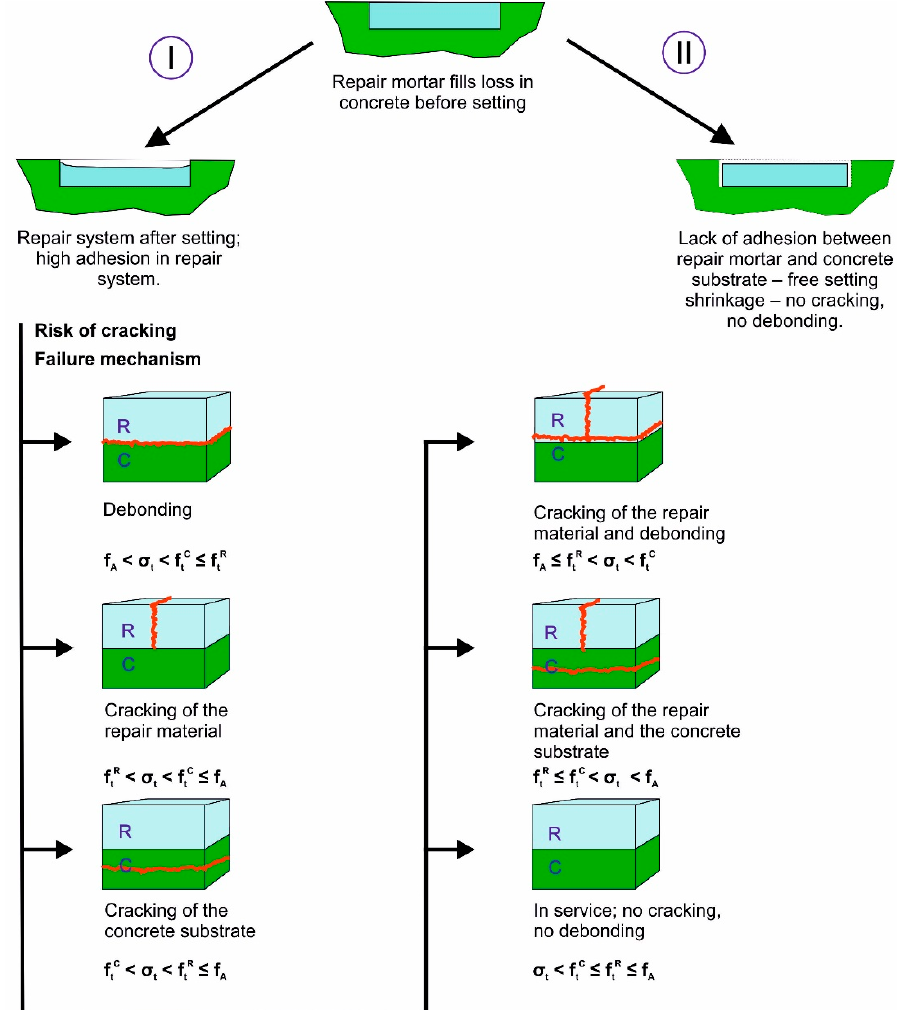
Figure 8. Damage models in repair systems: I—high adhesion in repair system, II—no adhesion, no cracking. Various kind of cracks in repaired system; σ t— internal shrinkage stress, f tR— repair material tensile trenght, f tC —concrete tensile strength, f A —adhesion strength.